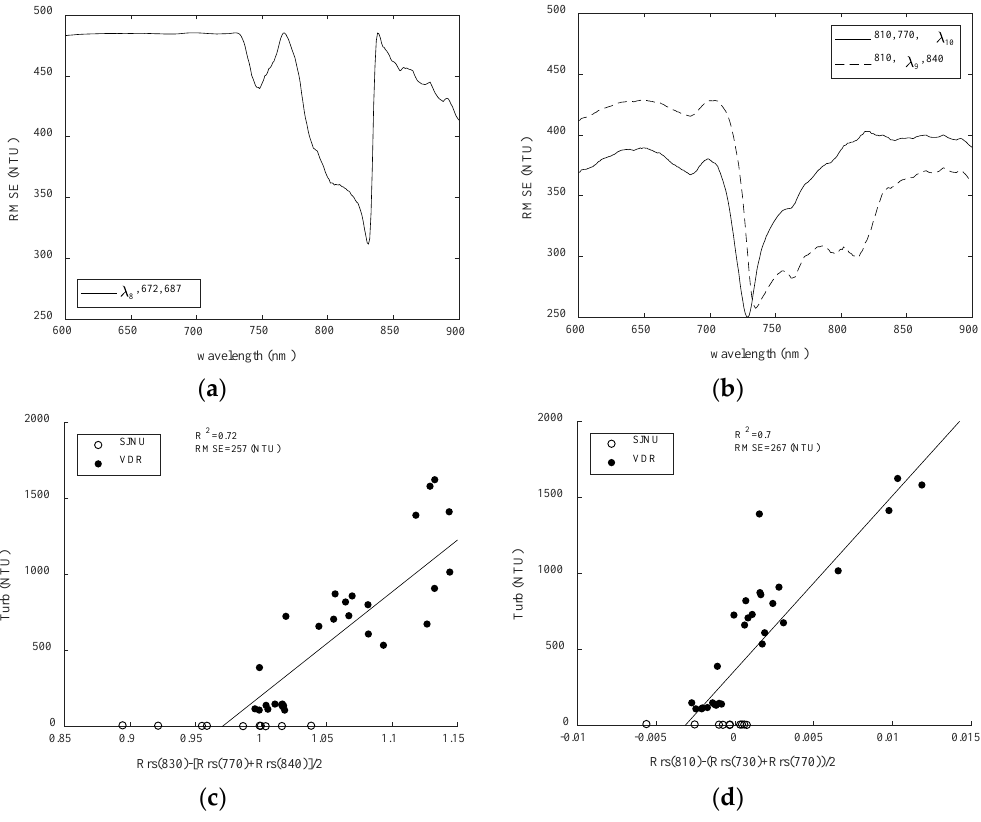
Figure 9. Turbidity results of the three-band model (T3) in SJNU and VDR. ( a ) Root mean square error (RMSE) variation between R rs ( λ 8 ) − [ R rs (770) + R rs (840)]/2 and measured turbidity when λ 8 is in the 400–900-nm range; ( b ) RMSE variation between R rs (810) − [ R rs −1 ( λ 9 ) + R rs (840)]/2 and measured turbidity when λ 9 is in the 400–900-nm range and R rs (810) − [ R rs (770) + R rs ( λ 10 )]/2 and measured turbidity when λ 10 is in the 400–900-nm range; ( c ) optimal correlation between R rs (830) − [ R rs (770) + R rs −1 (840)] and measured turbidity; ( d ) optimal correlation between R rs (810) − [ R rs (730) + R rs −1 (770)] and measured turbidity.